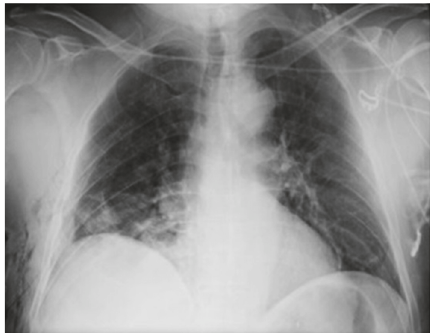
Figure 1: Chest radiography shows an enlarged cardiac